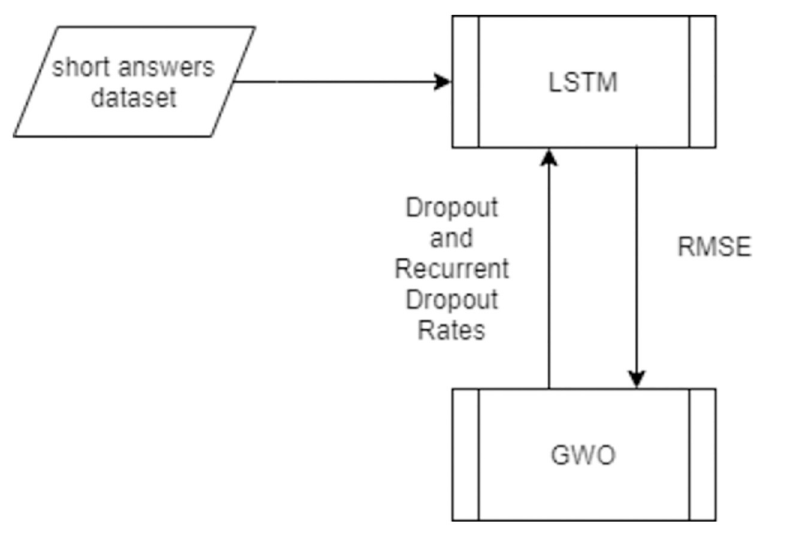
Fig 5. The LSTM optimization